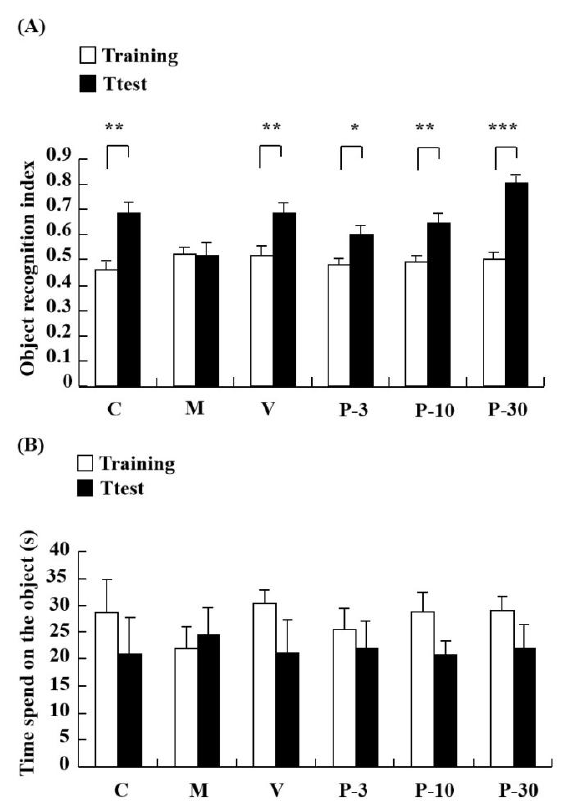
Figure 3. PAE e ff ects on d -gal-induced memory impairment in the novel object recognition (NOR) test. The mice were placed into the apparatus containing two identical objects and allowed to explore for 5 min in the training session. After 60 min, a novel object replaced one of two identical objects, and then the test session was performed. The object exploring time of each mouse in the training session and test session were recorded. ( A ) Object recognition index and ( B ) time spent on the object in seconds in NOR. Results are presented as mean ± SEM. n = 9, * p < 0.05, ** p < 0.01, *** p < 0.001, di ff erences between recognition index in the training and test session in the NOR. C, control group, C received saline; M, d -gal model group, M received 150 mg / kg d -gal; V, 100 mg / kg VE group, it received 100 mg / kg VE + 150 mg / kg d -gal; P-3, 3 mg / kg PAE group, it received 3 mg / kg PAE + 150 mg / kg d